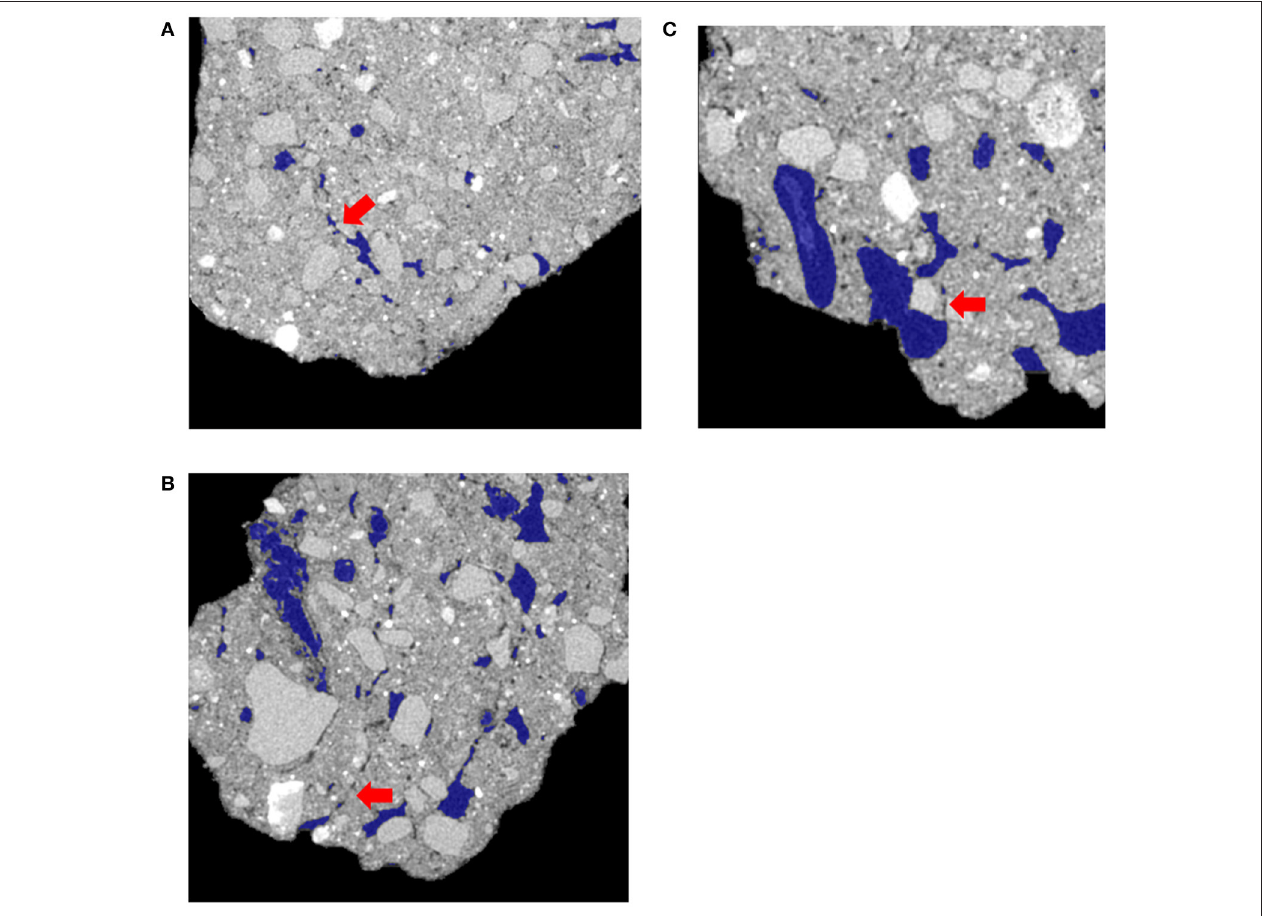
FIGURE 11 | Examples from the three different managements of how 3DMA missed pore material adjacent to non-biological pores, but identifies POM-Root and POM-NS pores correctly. (A) is from the conventional management, (B) is from the biologically based, and (C) is from the primary successional. The blue outlines are the pores identified by 3DMA. Red arrows on each figure indicate an example of missed porosity on each figure.